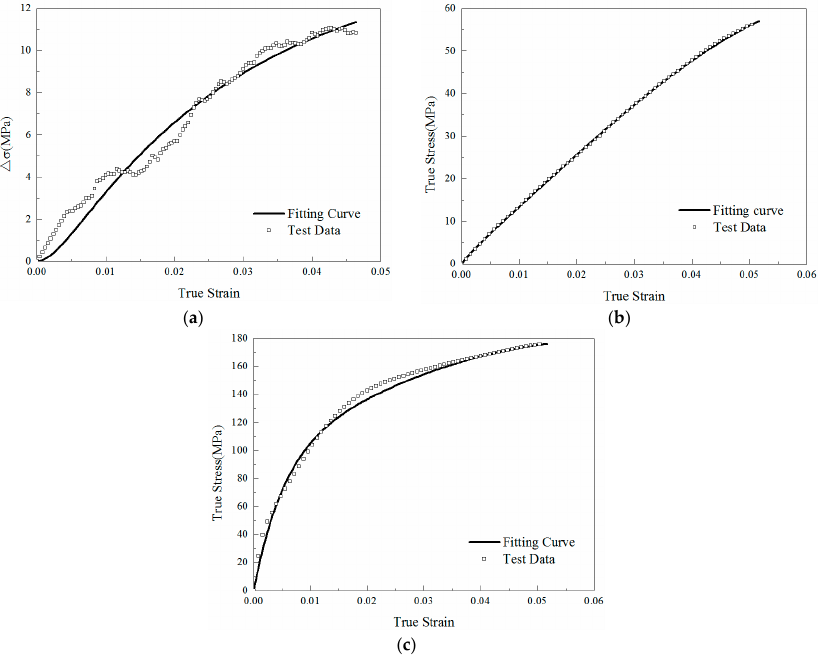
Figure 10. Fitting results of ZWT model parameters for pure epoxy resin (M0): ( a ) fitting results of difference curves Δσ for E 1 and θ 1 ; ( b ) fitting results of quasi-static strain rate (0.001 /s ) test data for E 0 , α and β ; ( c ) fitting results of high strain rate(4000 /s ) test data for E 2 and θ 2 . Table 3. ZWT model parameters of test materials.